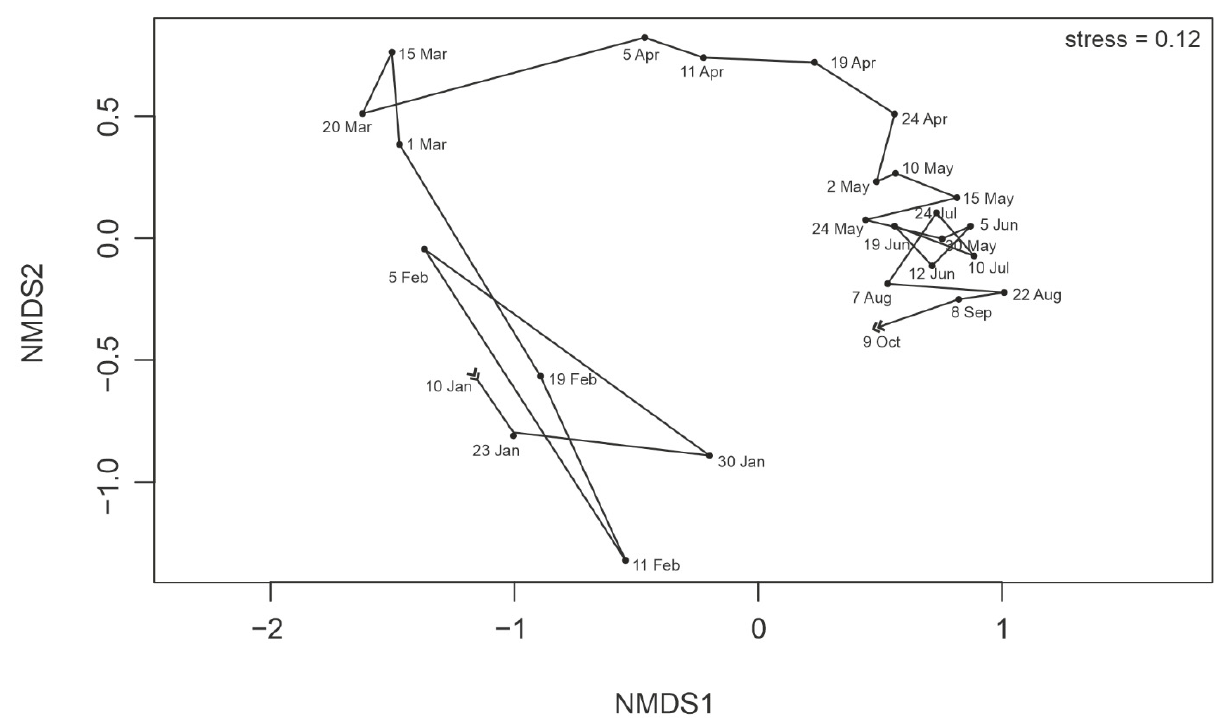
Figure 5. NMDS plot of Bray-Curtis dissimilarities between protist communities in 2013 (log-transformed abundance data). The beginning and end of the time trajectory are marked with an arrow.